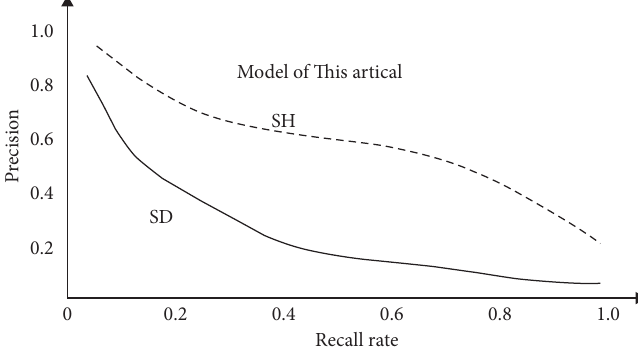
Figure 8: Precision-recall curve of the retrieval model in this